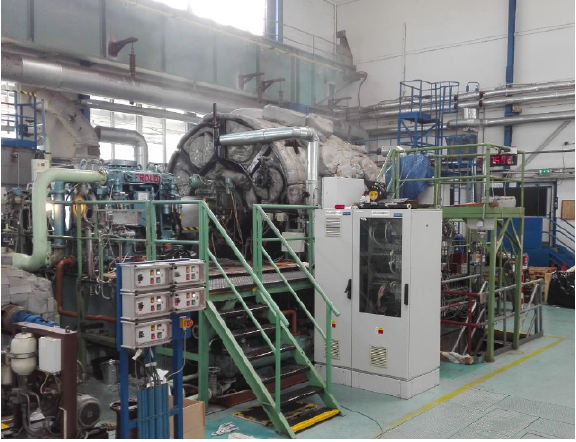
Figure 1. T10MW steam turbine test rig in Plzen,